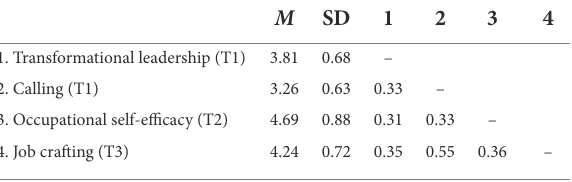
TABLE 1 The descriptive statistics and correlation